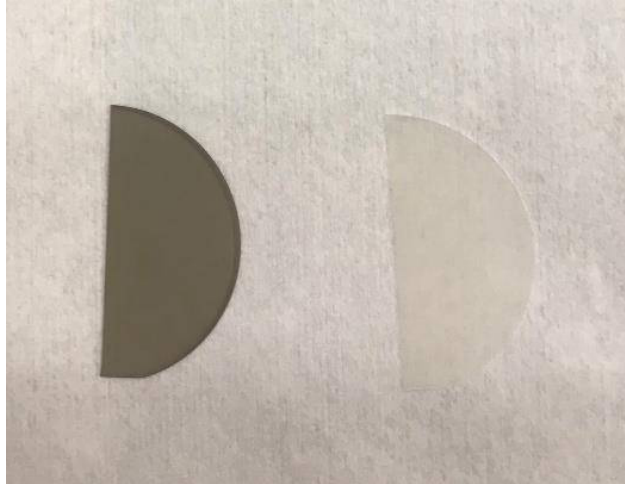
Figure 2. Photograph of LT GaN on sapphire samples. Left sample was 37 nm thick and grown with DMHy at 550 °C and right sample was 36 nm thick and grown with NH 3 at 450 °C.